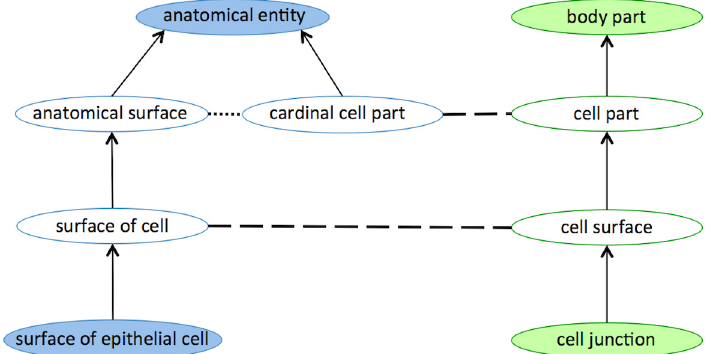
Fig 2. Example of two mappings taken from the UMLS-based Alignment between FMA and NCI ontologies, illustrated as blue and green respectively. Circles represent classes, arrows represent subclass relationships between classes, dashed lines represent mappings between classes, and dotted lines represent disjointness restrictions between classes. The circles filled in white represent the classes in the core fragments of the ontologies given the